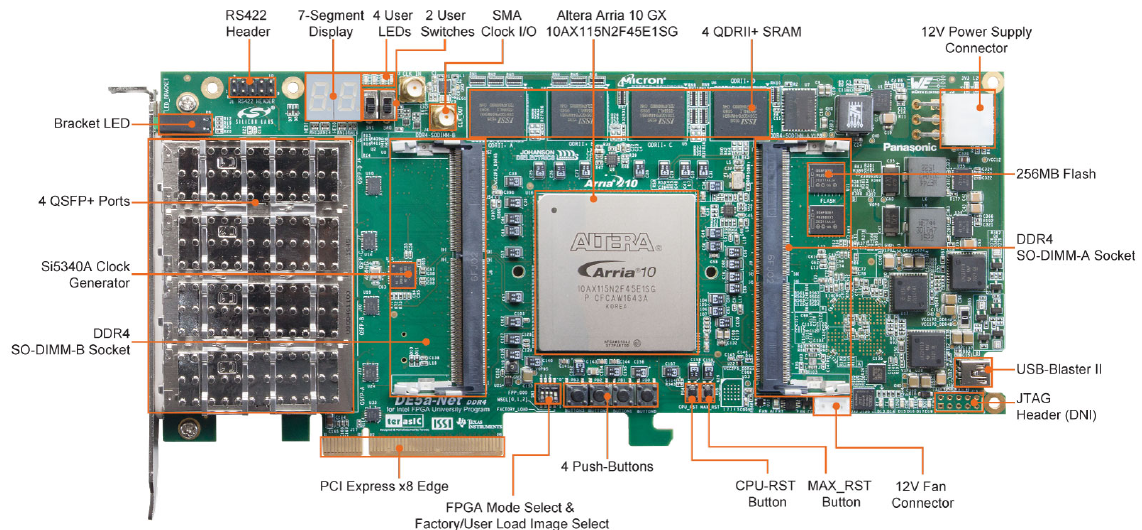
Figure 4. Intel DE5a-Net Arria R (cid:13) 10 GX FPGA board (Terasic, Taiwan)